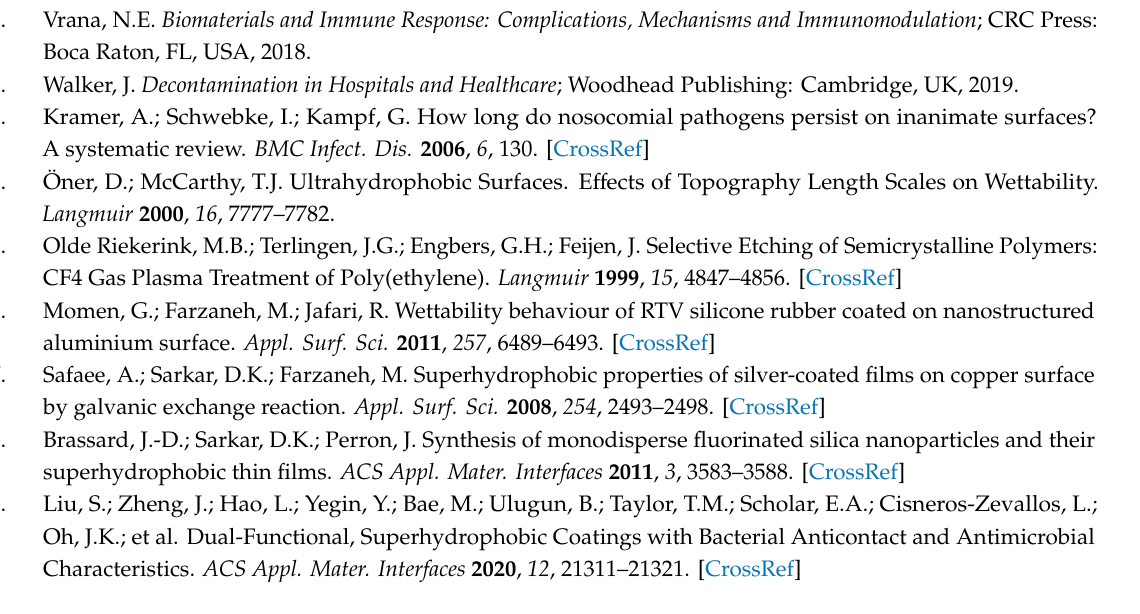
Figure S1: ATR-FTIR spectra, Table S1: QUATs: OTES molar ratio, Table S2: Variation of surface roughness, contact angle (CA) and contact angle hysteresis, (CAH), Table S3: Antibacterial activity, Video S1: OTES-QUATs treated cotton fiber, Video S2: OTES-QUATs treated tissue